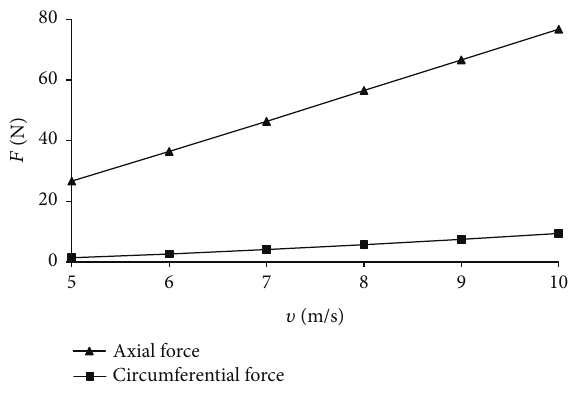
Figure 16: Variations of axial and circumferential forces with working conditions.